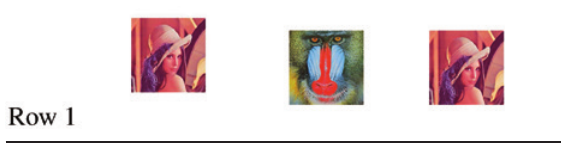
Table 6: Original Images.